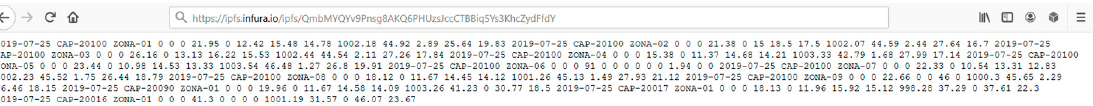
Figure 11. Hash InterPlanetary File System (IPFS).